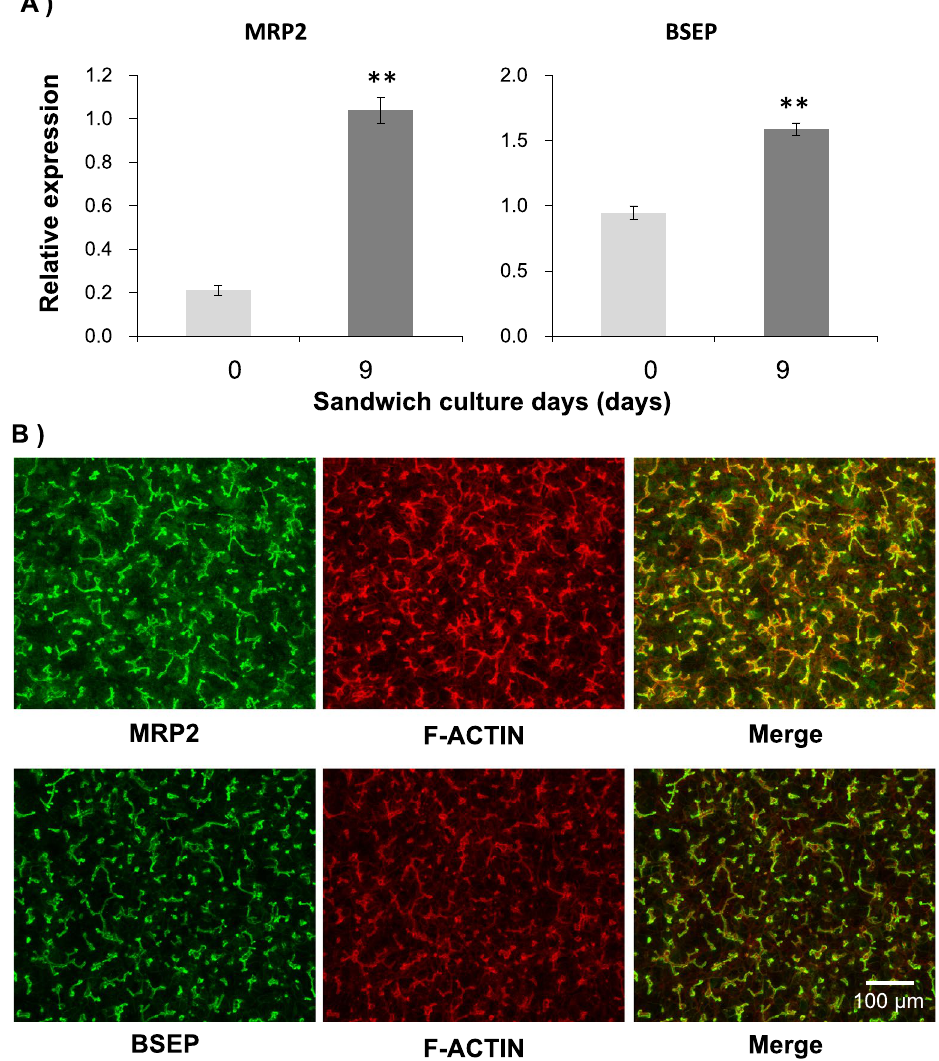
Figure 4. Gene expressions and the localization of biliary efflux transporters when the bile canaliculi were formed. Human-induced pluripotent stem cell-derived hepatocytes were cultured in a long-term maintenance medium for 28 days and then, they were sandwich-cultured in a maintenance medium for 9 days. ( A ) Expression levels of the biliary efflux transporters, multidrug resistance protein 2 (MRP2) and bile salt export pump (BSEP), were measured using quantitative polymerase chain reaction before and after sandwich culture. The bar shows the relative expression levels of MRP2 or BSEP . Pooled RNA from human liver was used for the standard curve, and the expression level was set as one. The relative expression level was calculated using the equation of the line for the standard curve. Data are presented as means ± S.D. (n = 3). ** Indicates that the expression significantly increased compared with that prior to the sandwich culture (P < 0.01). ( B ) Immunostaining images of MRP2 and BSEP after sandwich culture. Actin filaments were stained